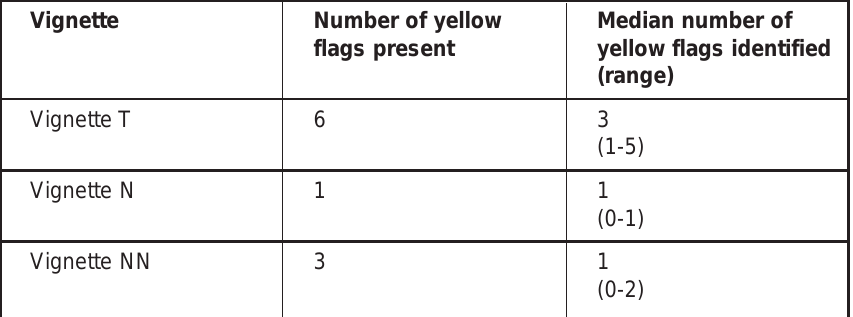
Table 3. Number of yellow flags present and median numbers identified for each